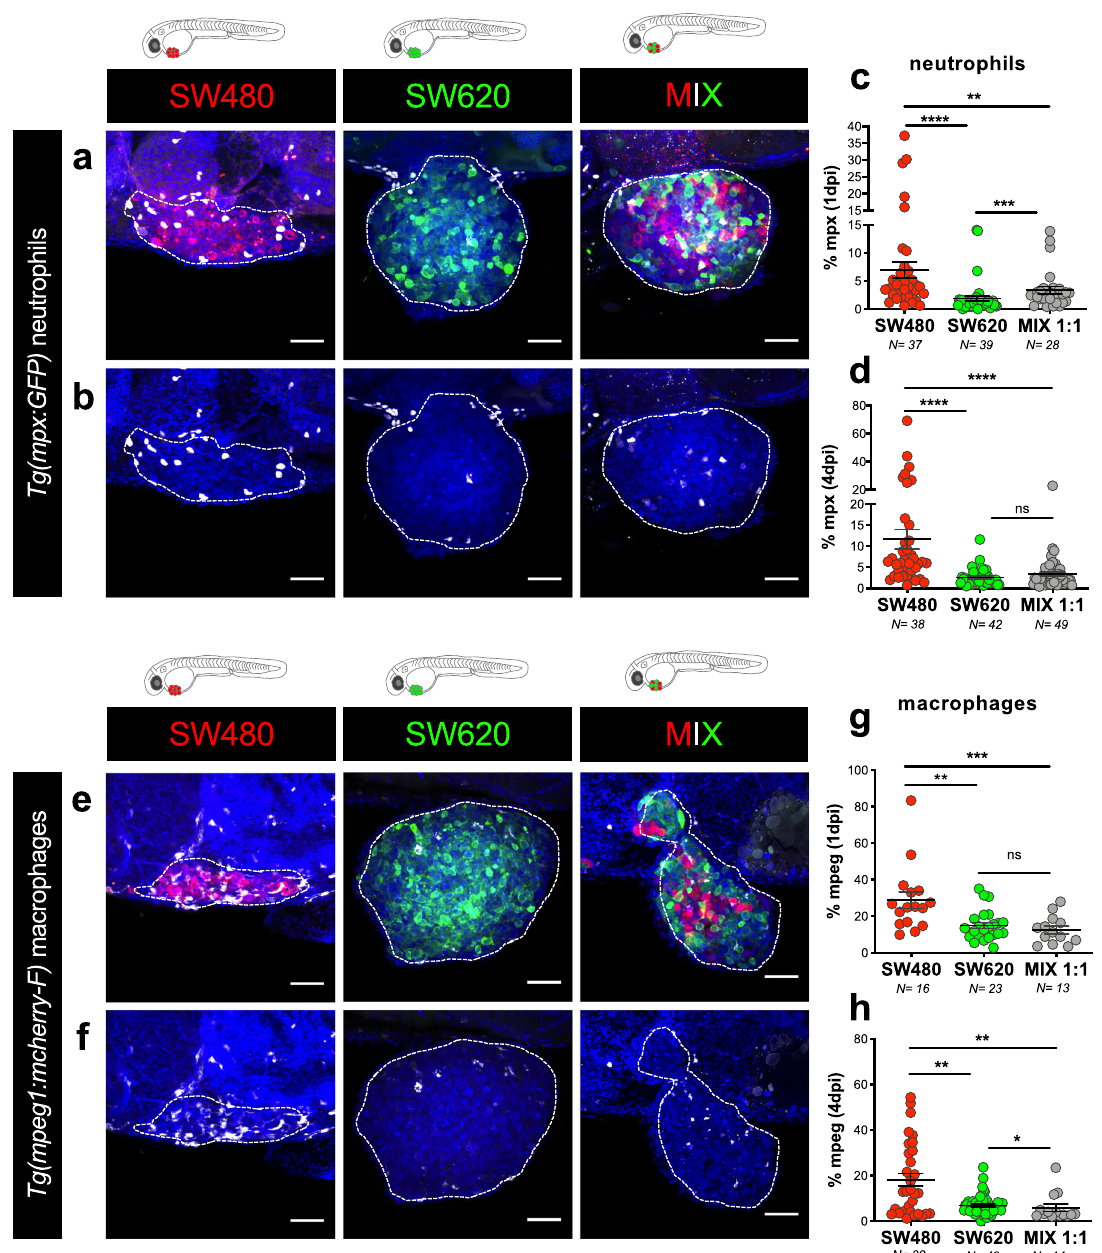
Fig. 3 SW480_regressor TME is enriched in innate immune cells. a , b Representative confocal projection images of neutrophils in SW480, SW620, and MIX tumors from Tg(mpx:eGFP) zebra fi sh xenografts at 4 dpi. c , d Quanti fi cation of neutrophils percentage (no. of neutrophils/no. of tumor cells x 100) within SW480, SW620, and MIX TME, at 1dpi ( c , **** P < 0.0001, *** P = 0.0002, ** P = 0.0094) and 4 dpi ( d , **** P < 0.0001, ns = 0.39). e , f Representative confocal projection images of macrophages in SW480, SW620, and MIX tumors from Tg(mpeg1:mcherry-F) zebra fi sh xenografts at 4dpi. g , h Quanti fi cation of macrophage percentage (no. of macrophages/no. of tumor cells x 100) within SW480, SW620, and MIX tumors, at 1dpi ( g , *** P = 0.0009, ** P = 0.0011, ns = 0.45) and 4 dpi ( h , 480 vs 620 ** P = 0.0089, 480 vs MIX ** P = 0.0025, * P = 0.024). SW480 (red) and SW620 (green), neutrophils (white) and macrophages (white) fake colors. Scale bars: 50 μ m. Dashed lines encircle tumor areas. Nuclei are stained with DAPI. N is depicted in the chart. Each dot represents one xenograft. Error bars indicate mean ± SEM (from three independent experiments). All data were analyzed using unpaired two-sided Mann – Whitney test. See also Supplementary Fig. 3. Source data are provided as a Source data fi polyclonal tumors, the presence of SW620, even in a 3:1 ratio (SW480:SW620), was suf fi cient to block neutrophil recruitment ( P = 0.0066) (Supplementary Fig. 5d). However, macrophage recruitment is only reduced when SW620 increases up to 50% of tumor cells (Supplementary Fig. 5e), suggesting that neutrophil and macrophage recruitment have different dynamics, possibly modulated by different mechanisms.